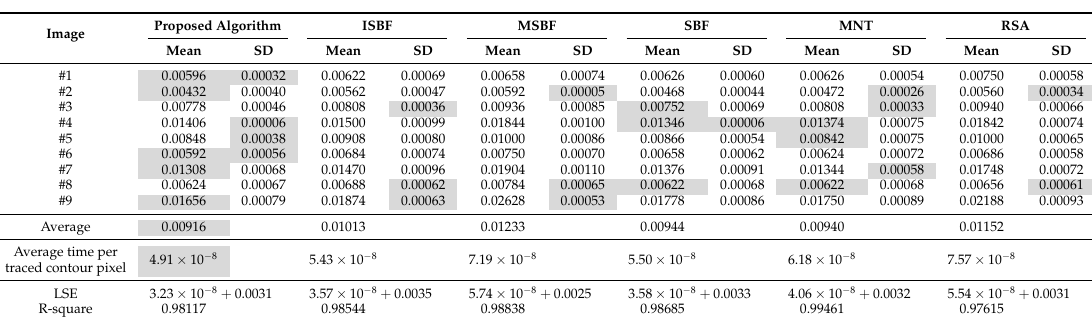
Table 8. Speed experimental result (units: